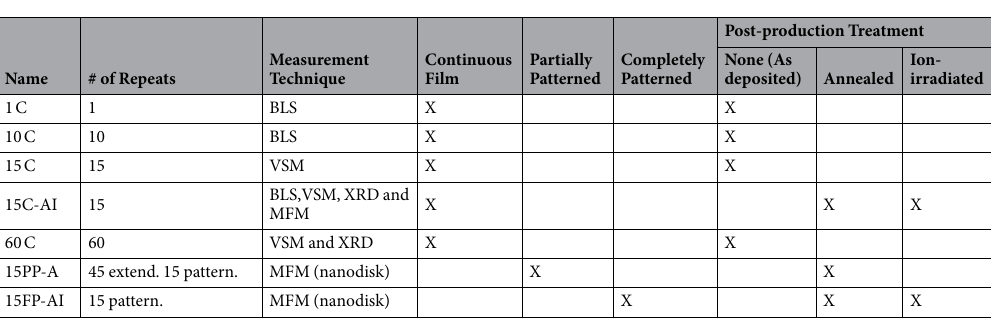
Table 1. Production parameters and measurement techniques for individual samples. Sample naming convention: [# of repeats] [Thin film property (continuous/fully or partially patterned)] − [Post production treatments (annealing and/or ion irradiated)]. Abbreviations: C for continuous, A for annealed, I for ion- irradiated during milling, PP for partially patterned, FP for fully